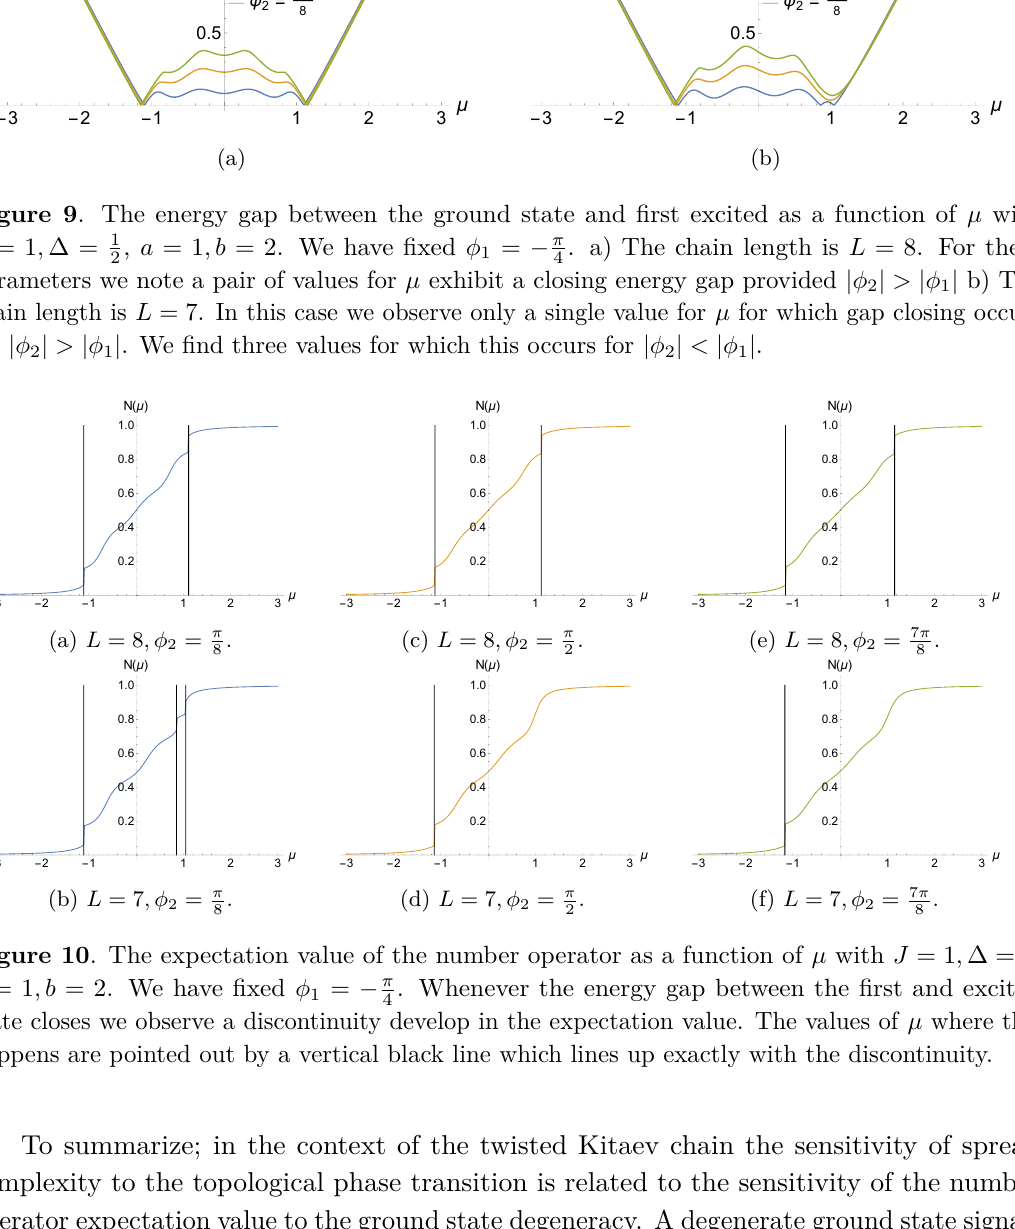
Figure 10 . The expectation value of the number operator as a function of µ with J = 1 , ∆ = 1 . Whenever the energy gap between the first and excited a = 1 , b = 2 . We have fixed φ 1 = − π 4 state closes we observe a discontinuity develop in the expectation value. The values of µ where this happens are pointed out by a vertical black line which lines up exactly with the